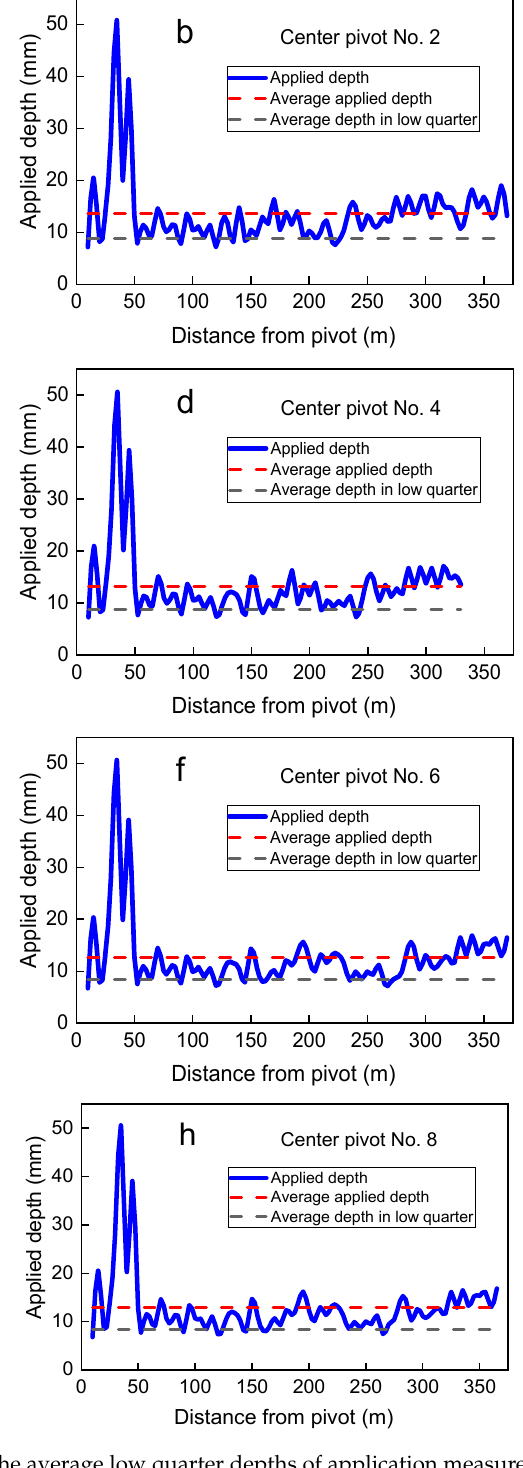
Figure 7. Water distribution patterns with the average depths and the average low quarter depths of application measured from the tested center pivot irrigation systems with modified laterals. The symbols ( a – h) correspond to the tested center pivot systems numbered 1 to 8.